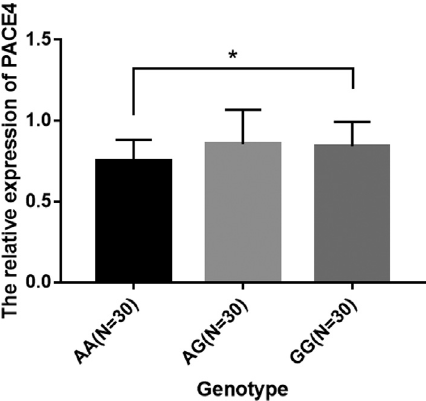
Figure 1 - Expression levels of PACE4 in three different genotypes.